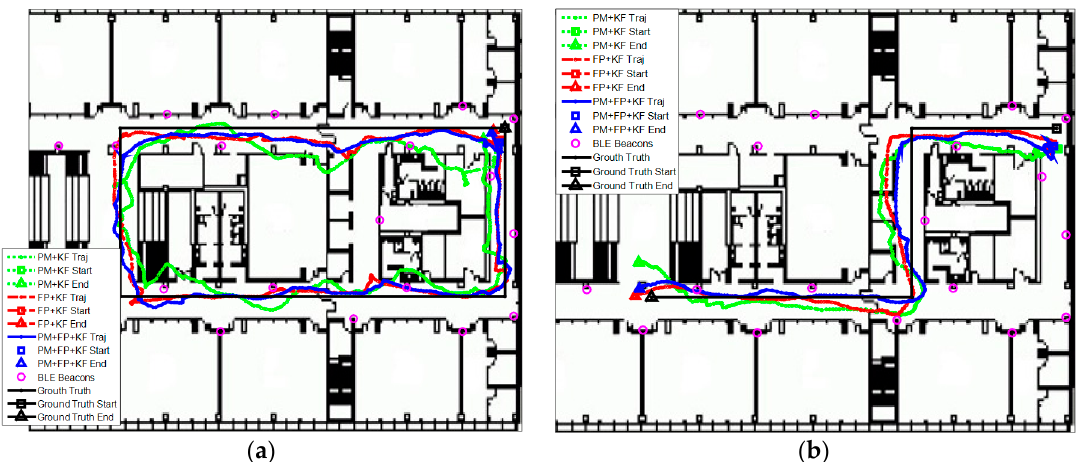
Figure 12. Estimated trajectories with dense deployment of BLE beacons using the proposed algorithm, PM + EKF, and FP + EKF: ( a ) Trajectory I; and ( b ) Trajectory II.